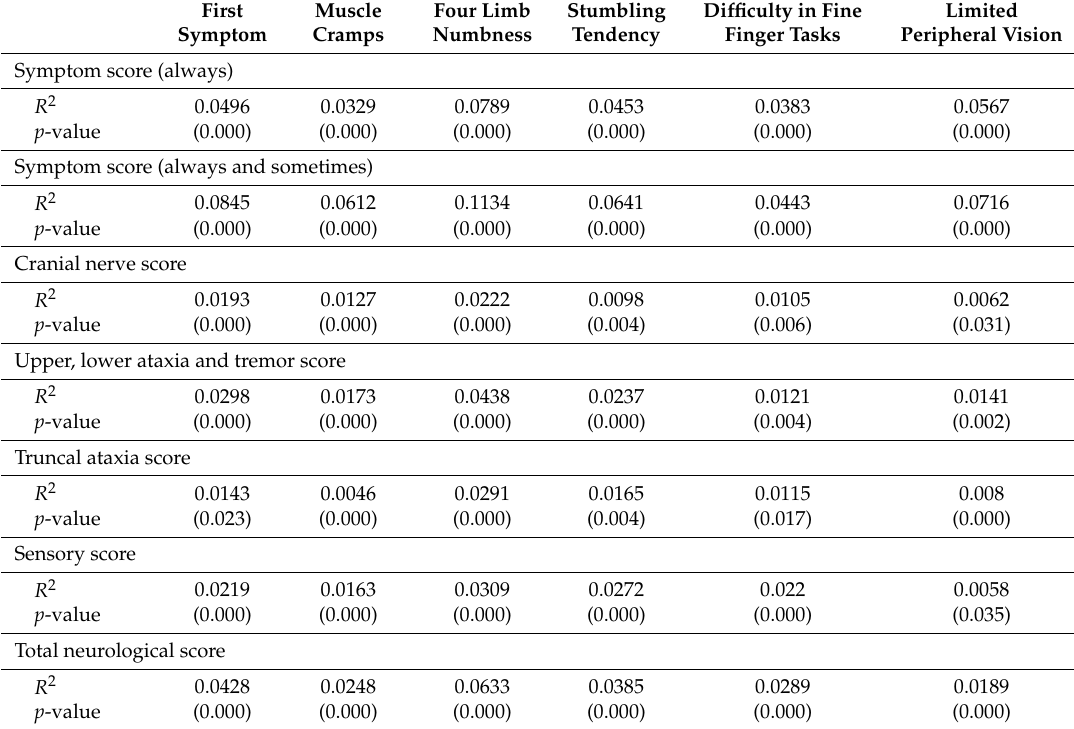
Table 14. Score of signs and onset of symptoms in each area.